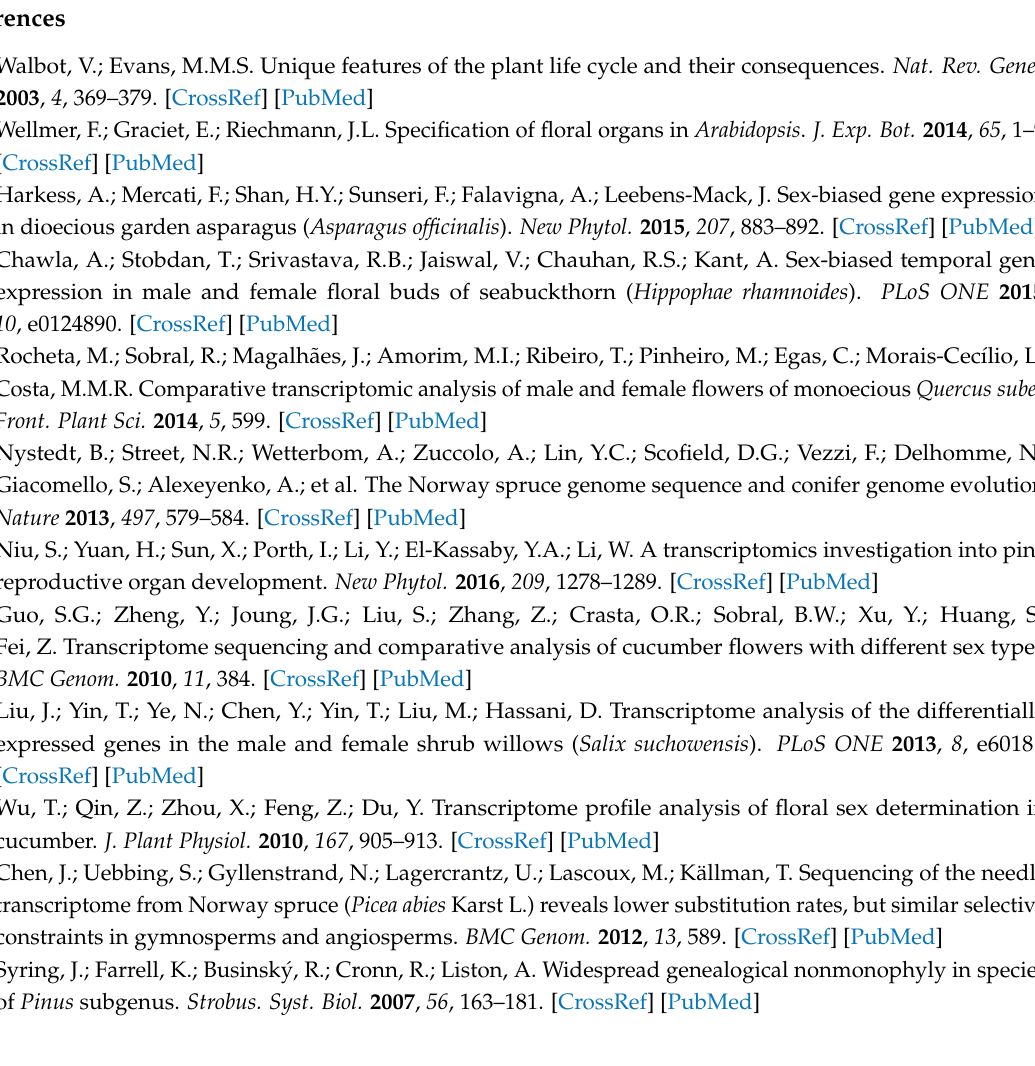
functional classification of Pinus bungeana unigenes. Figure S6: Spearman correlation matrix of experimental replications of transcriptome sequencing datasets of Pinus bungeana . Figure S7: Analysis of differential unigenes expression. In total, 12,073 unigenes were identified as differentially expressed between male and female conelets, which comprised 5766 unigenes that were up-regulated and 6307 unigenes that were down-regulated. Figure S8: Venn diagram of differential expression unigenes within three biological replications from male and female conelets, respectively. Figure S9: Analysis of differential unigenes expression. Figure S10: KEGG pathways enriched for differentially expressed genes of male and female conelets in Pinus bungeana. Figure S11: Plant hormone signal transduction in Pinus bungeana was adapted from the Kyoto Encyclopedia of Genes and Genomes (KEGG) pathway. Figure S12: Cysteine and Methionine metabolism pathway was adapted from the KEGG. Figure S13: Results of the Bayesian assignment analysis of Pinus bungeana using the program STRUCTURE. Figure S14: Dendrogram for natural six populations of Pinus bungeana based on 17 SSR loci. Table S1: Information of SSR Primers of Pinus bungeana used in this study. Table S2: Differently expressed genes in plant hormone signal transduction and photosynthesis metabolism pathways. Table S3: Results of the analysis of molecular variance (AMOVA) performed on six populations in Pinus bungeana using 17 microsatellite markers. Acknowledgments: We are very grateful to Aureliano Bombarely and three anonymous reviewers for their constructive comments. This work was co-supported by the National Natural Science Foundation of China (41101058, 31470400) and the Program for Changjiang Scholars and Innovative Research Team in University (PCSIRT, No.